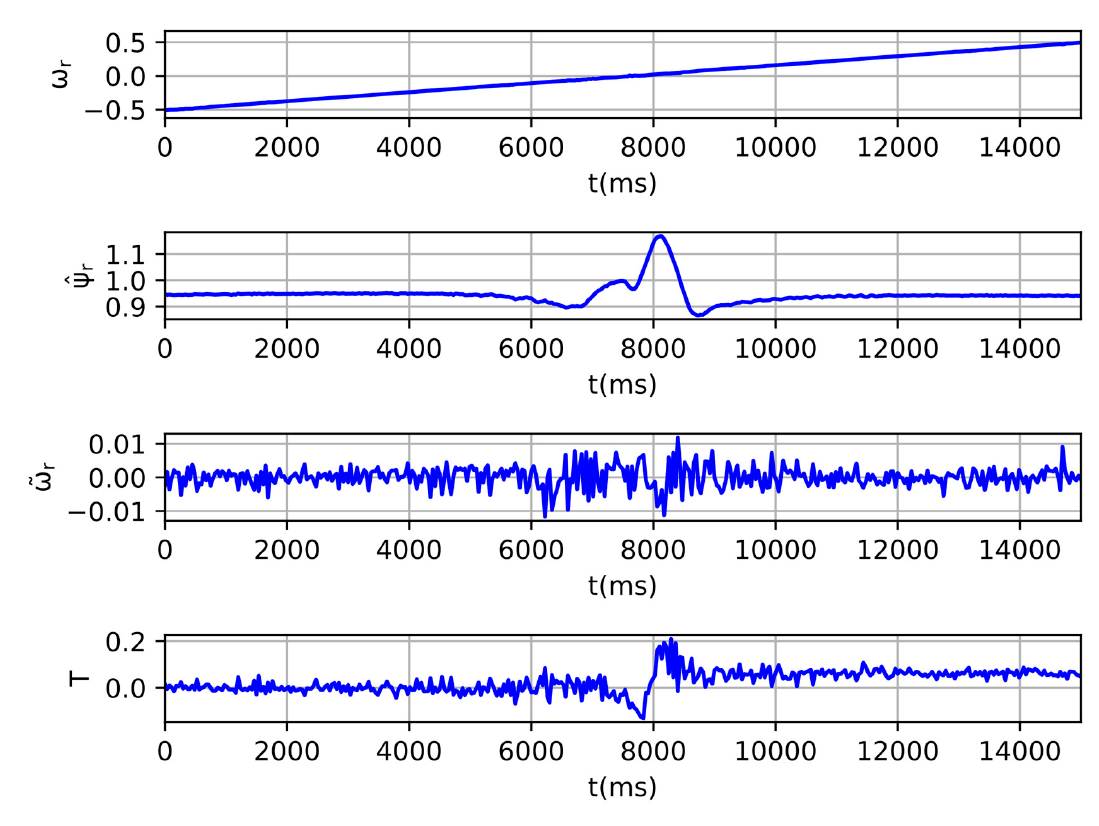
Figure 14. Experimental results during rotor direction change using the open-loop control system.